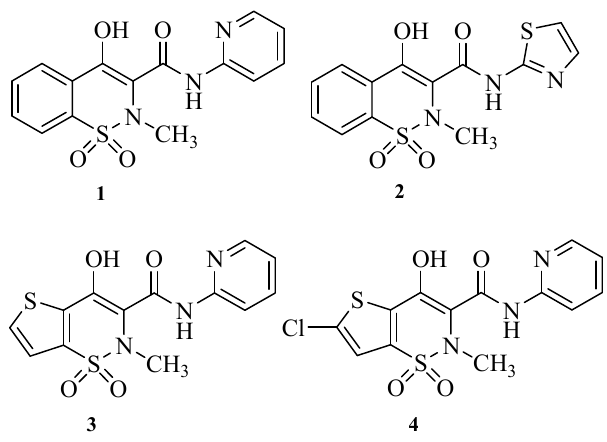
Figure 1. Oxicam class